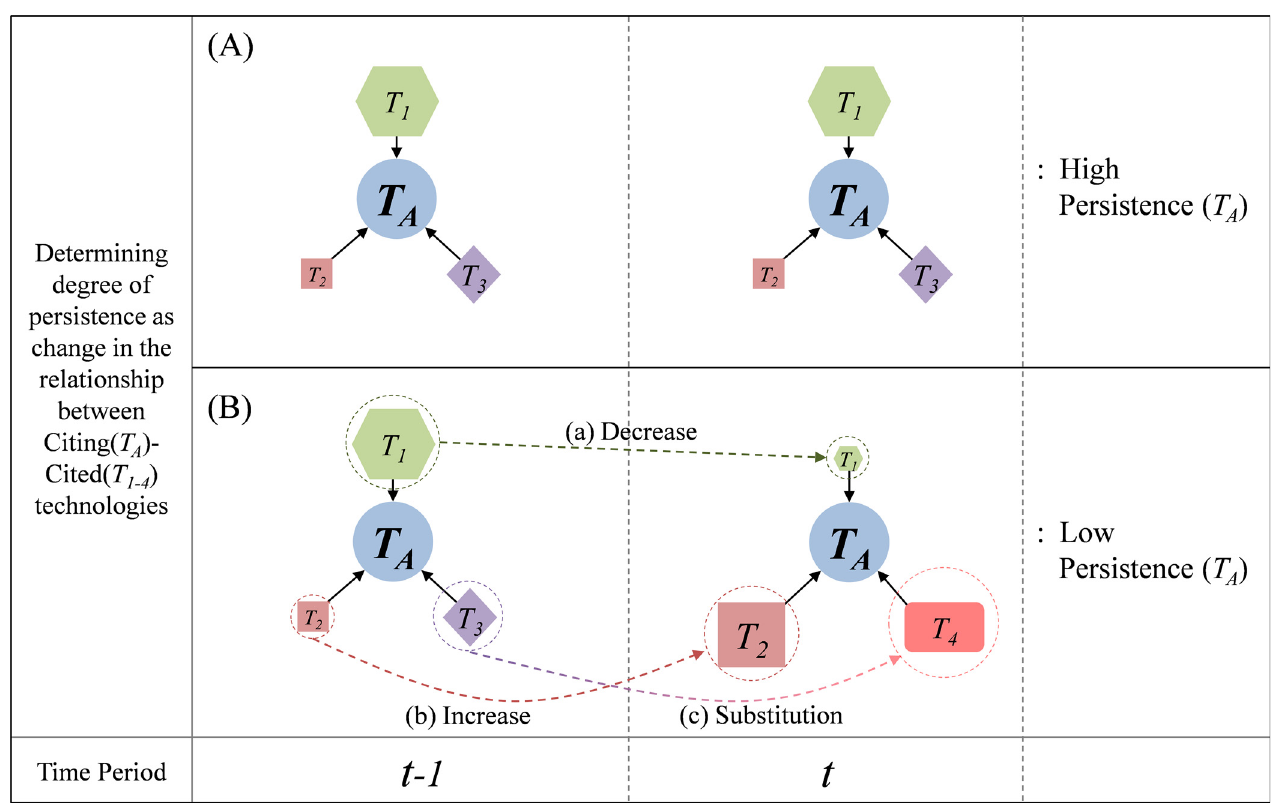
Fig 4. Conceptual Diagram for Determining Degree of Persistence.